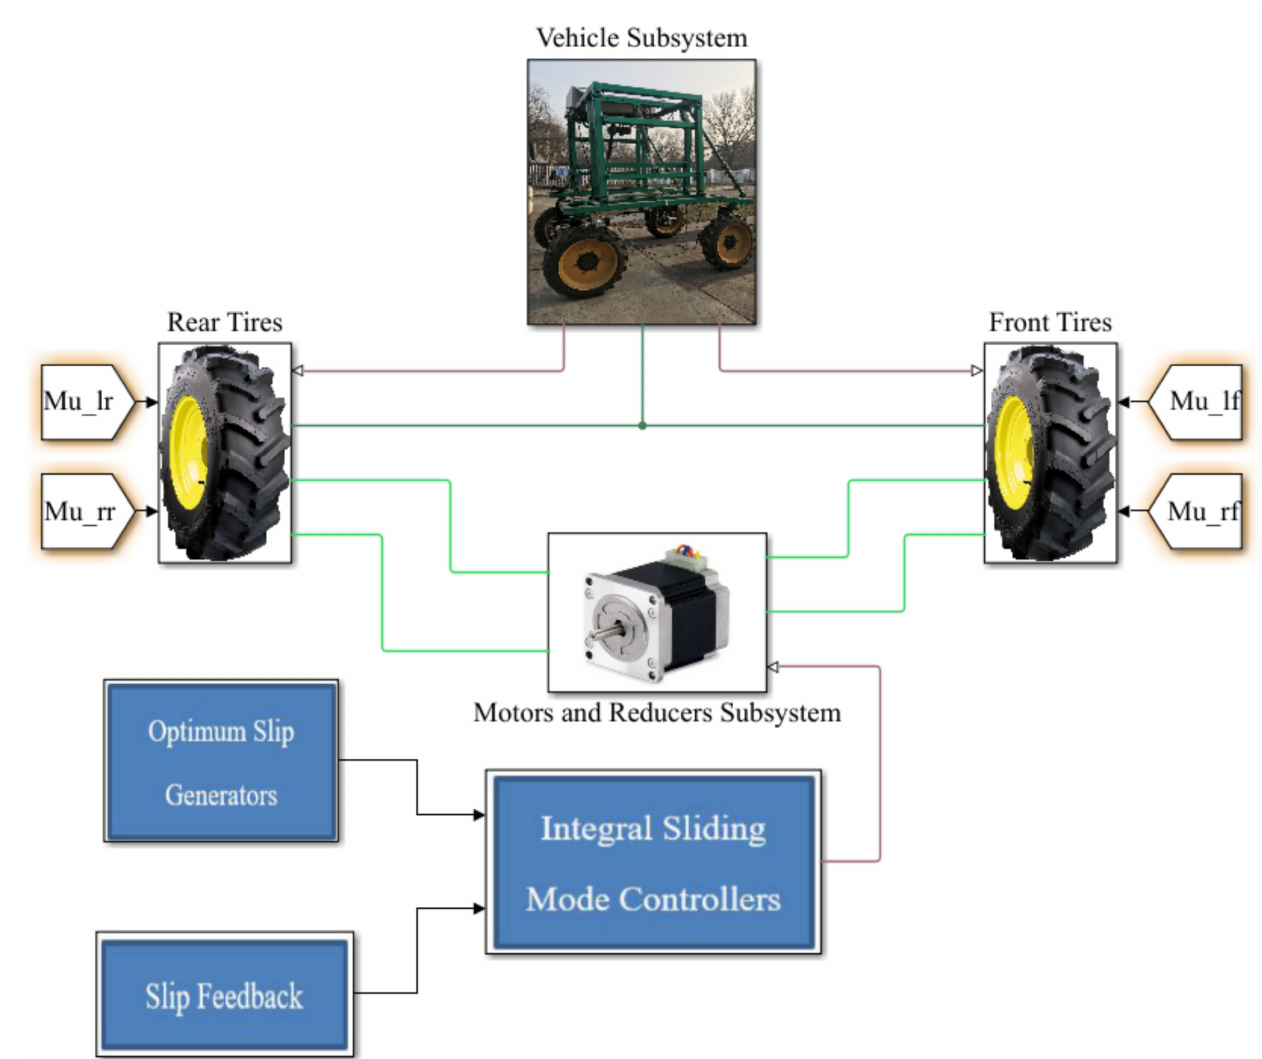
Figure 5. Diagram of the observer and sliding mode